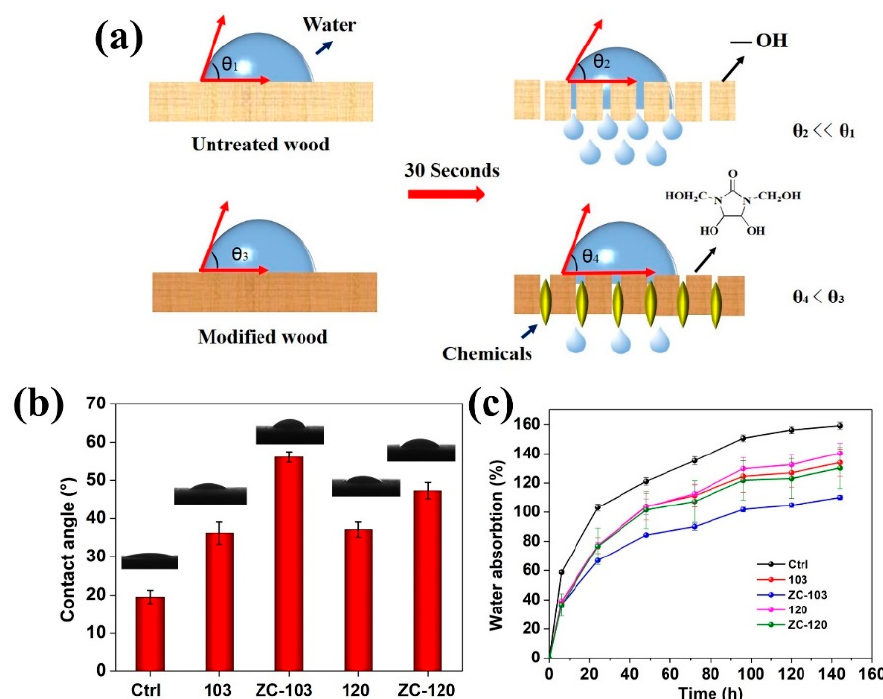
Figure 11. Schematic diagram of the permeation of the deionized water on the surface of the wood samples ( a ); the surface contact angle of the untreated and treated samples ( b ); the water absorption of the untreated and treated samples ( c ).